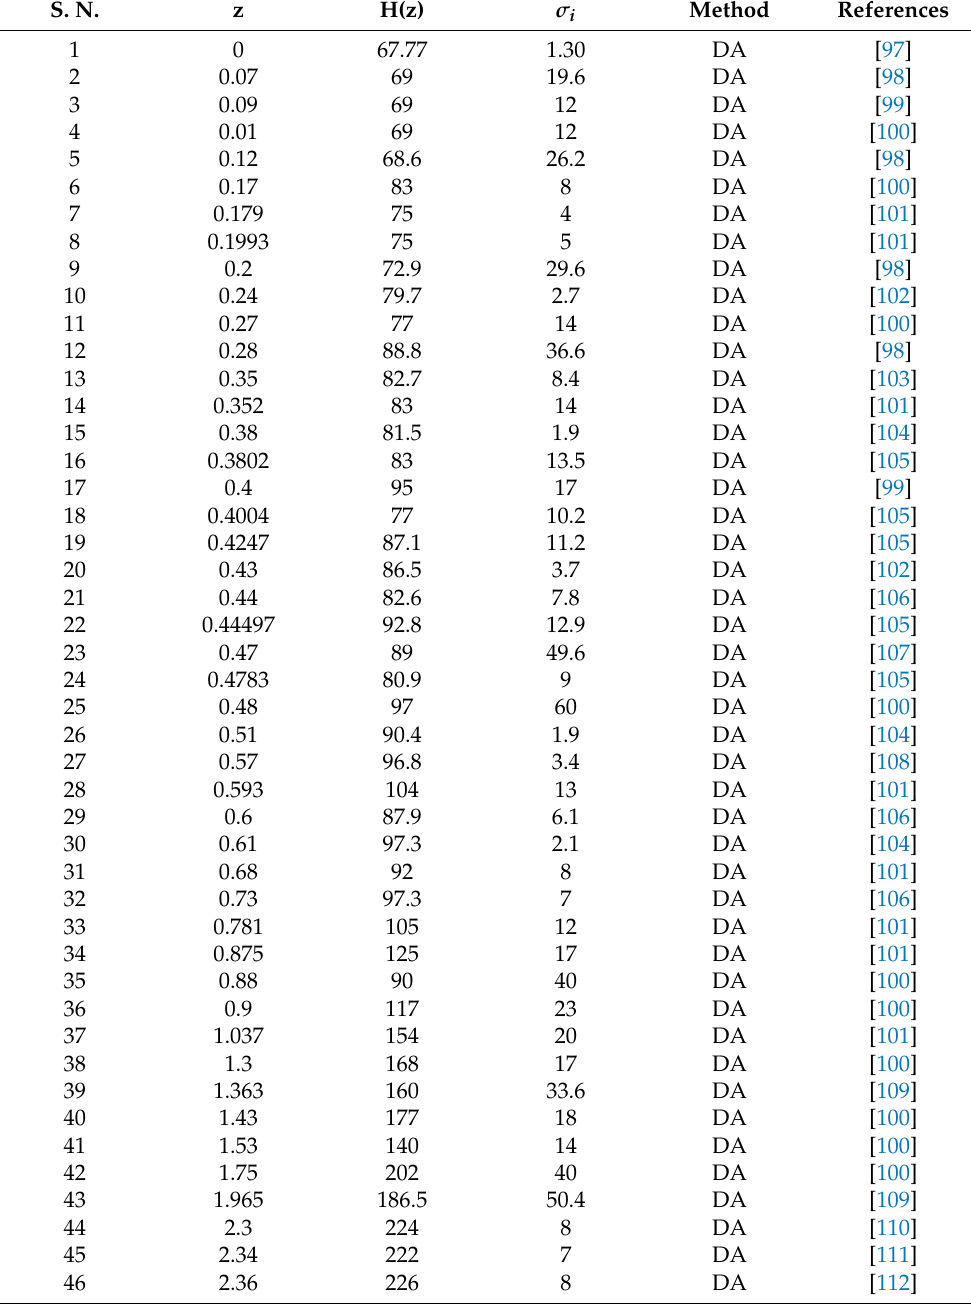
Table A1. Hubble parameter H(z) with redshift and errors σ i